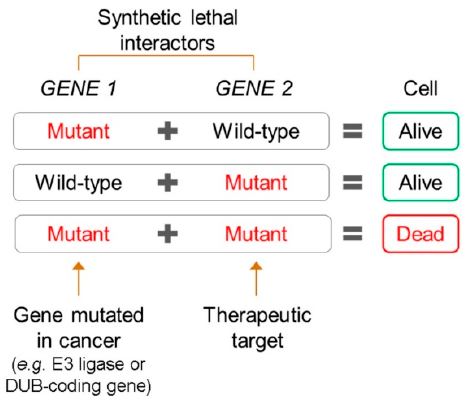
Figure 3. The synthetic lethal paradigm in cancer targeting. Synthetic lethality describes a rare and lethal genetic interaction occurring between two unlinked genes. Mutually exclusive mutations or alterations occurring in either GENE 1 or GENE 2 are viable, while simultaneous co-occurrence is lethal. In a therapeutic context, cancer cells with genetic defects in a histone E3 ubiquitin ligase or DUB gene (e.g., GENE1 ) can be selectively targeted and killed by downregulating or inhibiting the expression and/or function of a synthetic lethal interactor ( GENE 2 ; drug target).